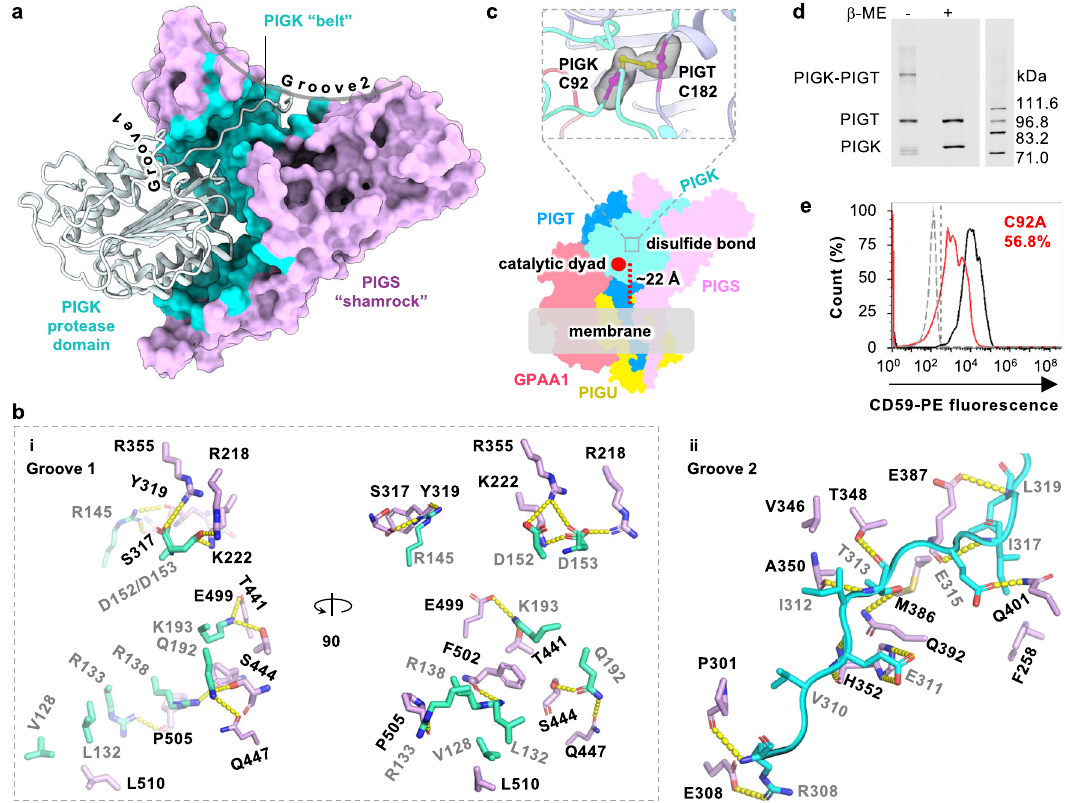
Fig. 5 PIGS and PIGT place PIGK and its catalytic dyad in a position suitable for catalysis. a PIGS (surface, pink) holds PIGK (ribbon) by embracing the protease domain using one of the shamrock grooves and hosting the loop region in another groove. The buried surface is colored cyan. b Detailed interactions between PIGK and PIGS at Groove 1 ( i ) and Groove 2 ( ii ). PIGK residues (cyan) are indicated with gray texts and PIGS residues (light purple) are labeled with black texts. Dashed lines (yellow) indicate distances within 3.6 Å. c An inter-subunit disul fi de bond (PIGT C182 / PIGK C92) (magenta) nails PIGK (cyan) onto the PIGT (blue) (top). This and the other interactions fi x PIGK in a position such that the catalytic dyad (red dot) is ~22 Å “ above ” the membrane interface (gray shading). This geometry would suit interactions with GPI which is expected to insert into the membrane by the phosphatidyl moiety with its hydrophilic glycan chains (measuring ~25 Å in the extended form) stemming from the membrane to meet with the catalytic dyad. The cryo- EM density for the disul fi de bond is shown gray. A GPI-T structure (bottom) color-coded as indicated shows the approximate position of the disul fi de bond. d Veri fi cation of the PIGK-PIGT disul fi de bond. SDS-PAGE in-gel fl uorescence shows a high-molecular-weight band (PIGK-PIGT) in the absence of, but not in the presence of, the reducing agent β -mercaptoethanol ( β -ME) at the cost of the individual PIGT/PIGK bands. Free PIGT/PIGK bands under non- reducing conditions were probably from uncomplexed PIGT/PIGK proteins due to the uneven expression level of all the fi ve subunits. Other subunits were also co-transfected but were invisible owing to their lack of the TGP-tag 41 . Theoretical molecular weights of home-made fl uorescent molecular markers 69 are labeled on the right. Shown is a representative result of three independent experiments. The uncropped image is available in the Source Data fi le. e Disruption of the PIGT-PIGK disul fi de bond by PIGK C92A causes loss of GPI-T activity. PIGK knockout cells expressing TGP-tagged wild-type (black), C92A (red), or a control membrane protein (gray) were gated by TGP fl uorescence (for the expression of PIGK), and the sub-population was analyzed for surface staining of the reporter GPI-AP (CD59) by fl ow cytometry using phycoerythrin (PE)-conjugated antibodies. C92A showed an apparent activity of 61.0 ± 6.3% (s.e.m., n = 3) compared to the wild-type PIGK. A vertical line indicates the threshold for CD59 fl uorescence. Shown is a representative result from three independent experiments. Source data are